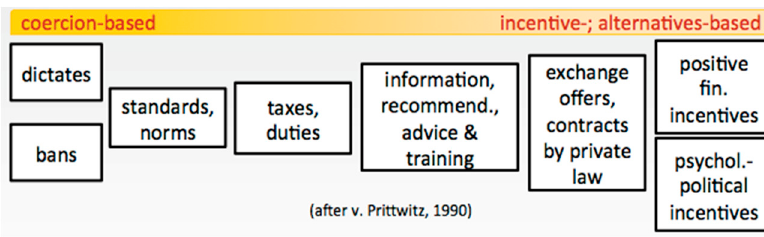
Figure 2. An instrument typology, as an analytical reference point.